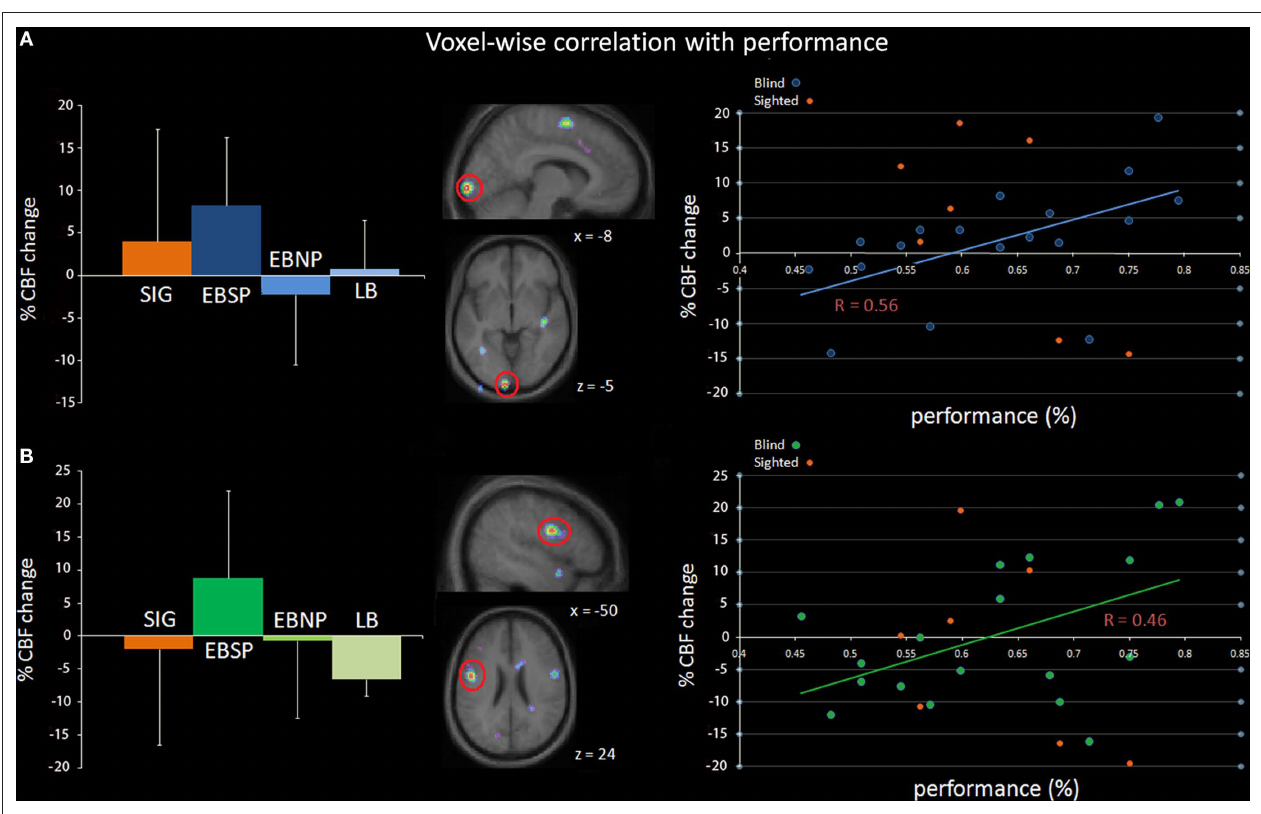
group for each region relative to baseline while the middle column shows sagittal and horizontal slices highlighting the two regions. The right column illustrates the correlation between percent CBF change and performance across all blind subjects. Note that the data points for sighted subjects are also included in the scatter plot for comparison purposes, but were not included in the